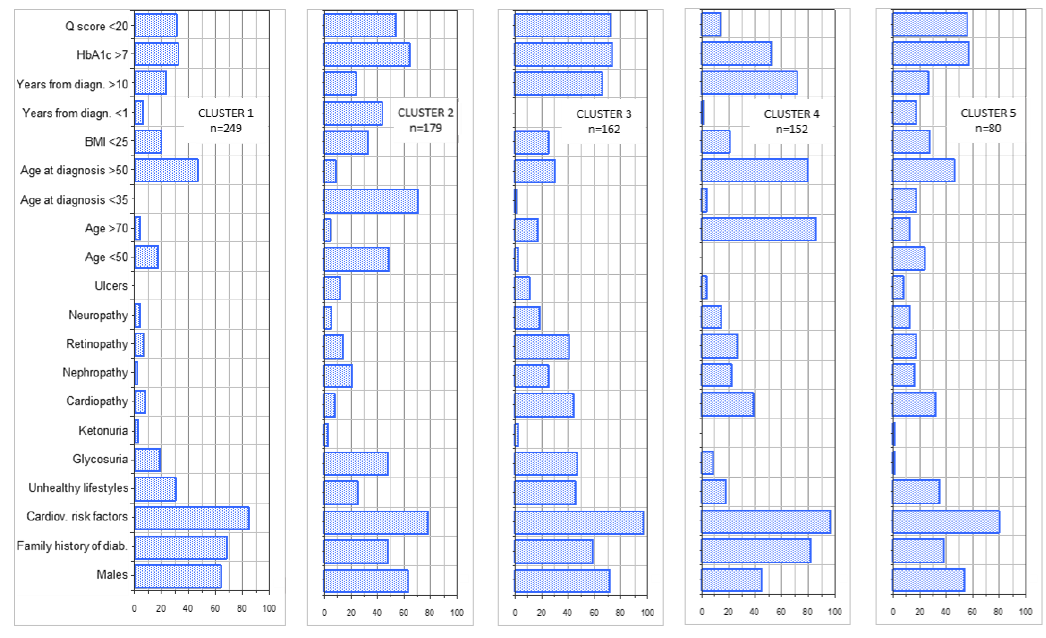
Figure 3. Composition of the five clusters (percentage of each of the 17 variables used in MCA).